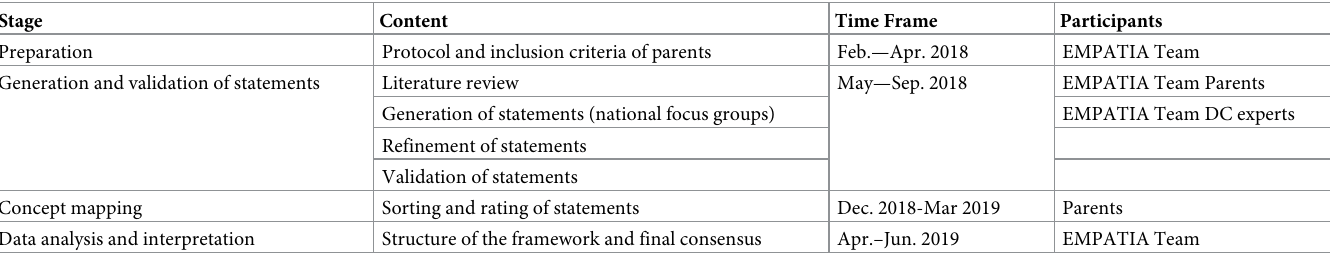
Table 1. Stages, content, time frame and participants of the concept mapping